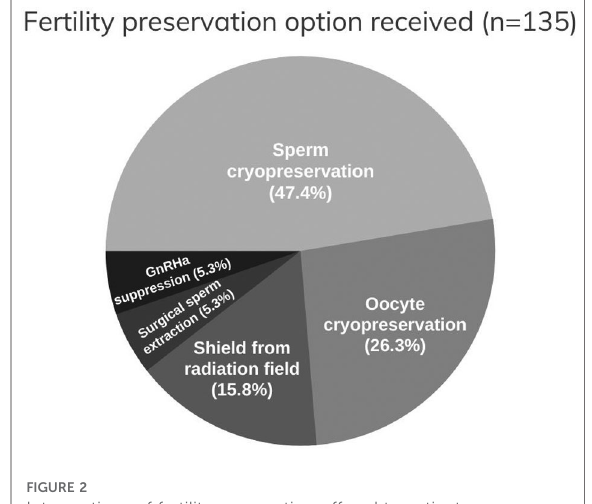
FIGURE 2 Interventions of fertility preservation offered to